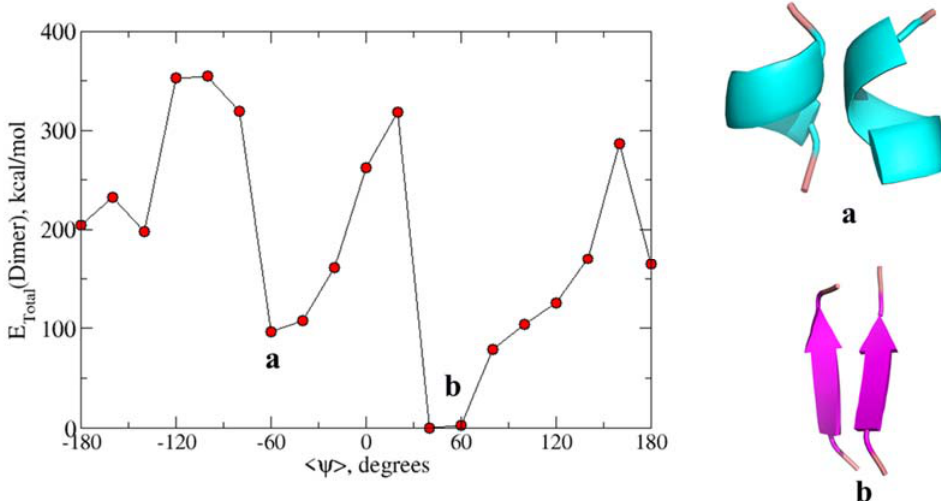
Figure 4. Calculated total energy of conformations at different ψ angles using the M06-2X/6-31+G* level of theory for QVEVKSEKLD. ( a ) The secondary structure corresponds to the alpha helix dimer and ( b ) Beta-sheet dimer.